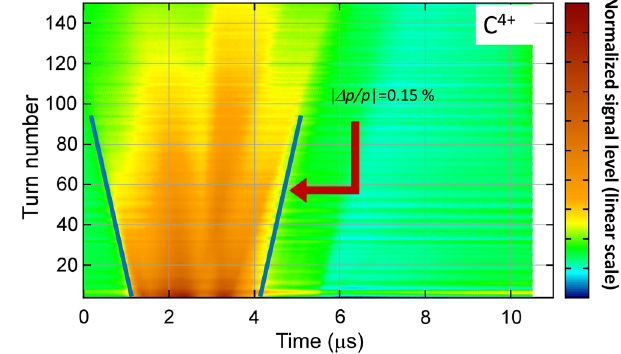
FIG. 7. Time-turn plane view of the free run of C 4 þ .